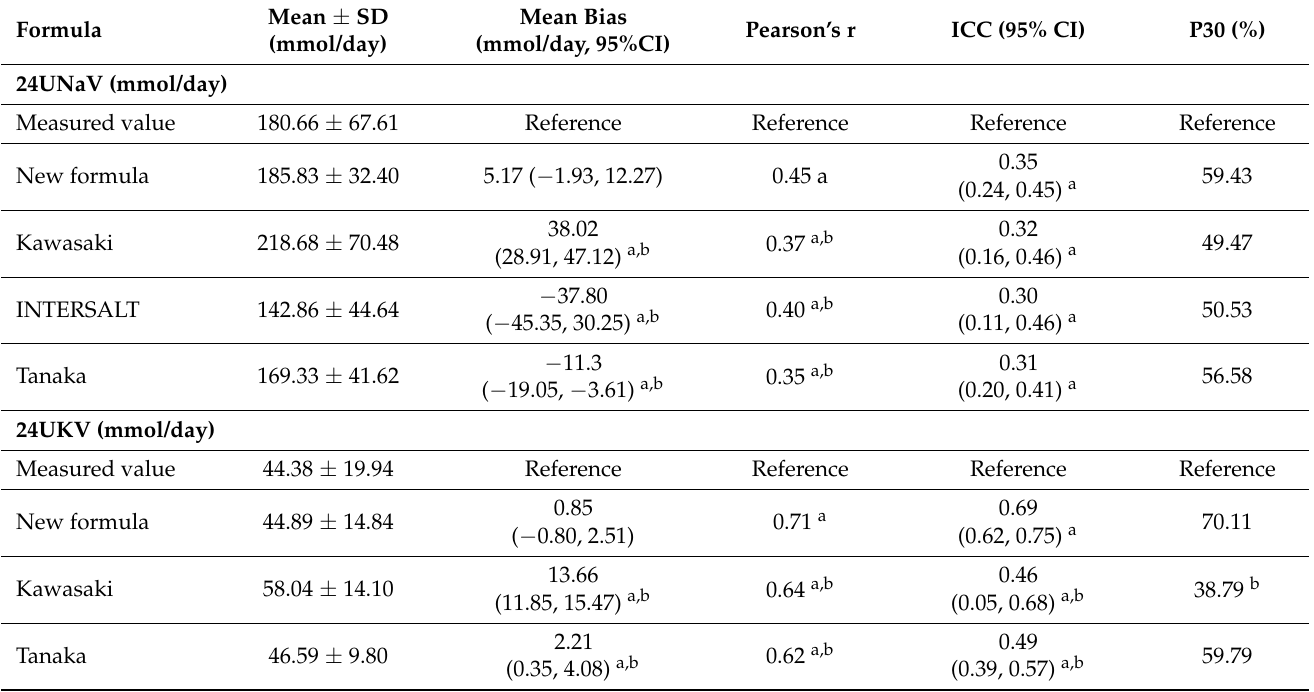
Table 4. Comparison between measured and estimated values of 24UNaV and 24UKV.